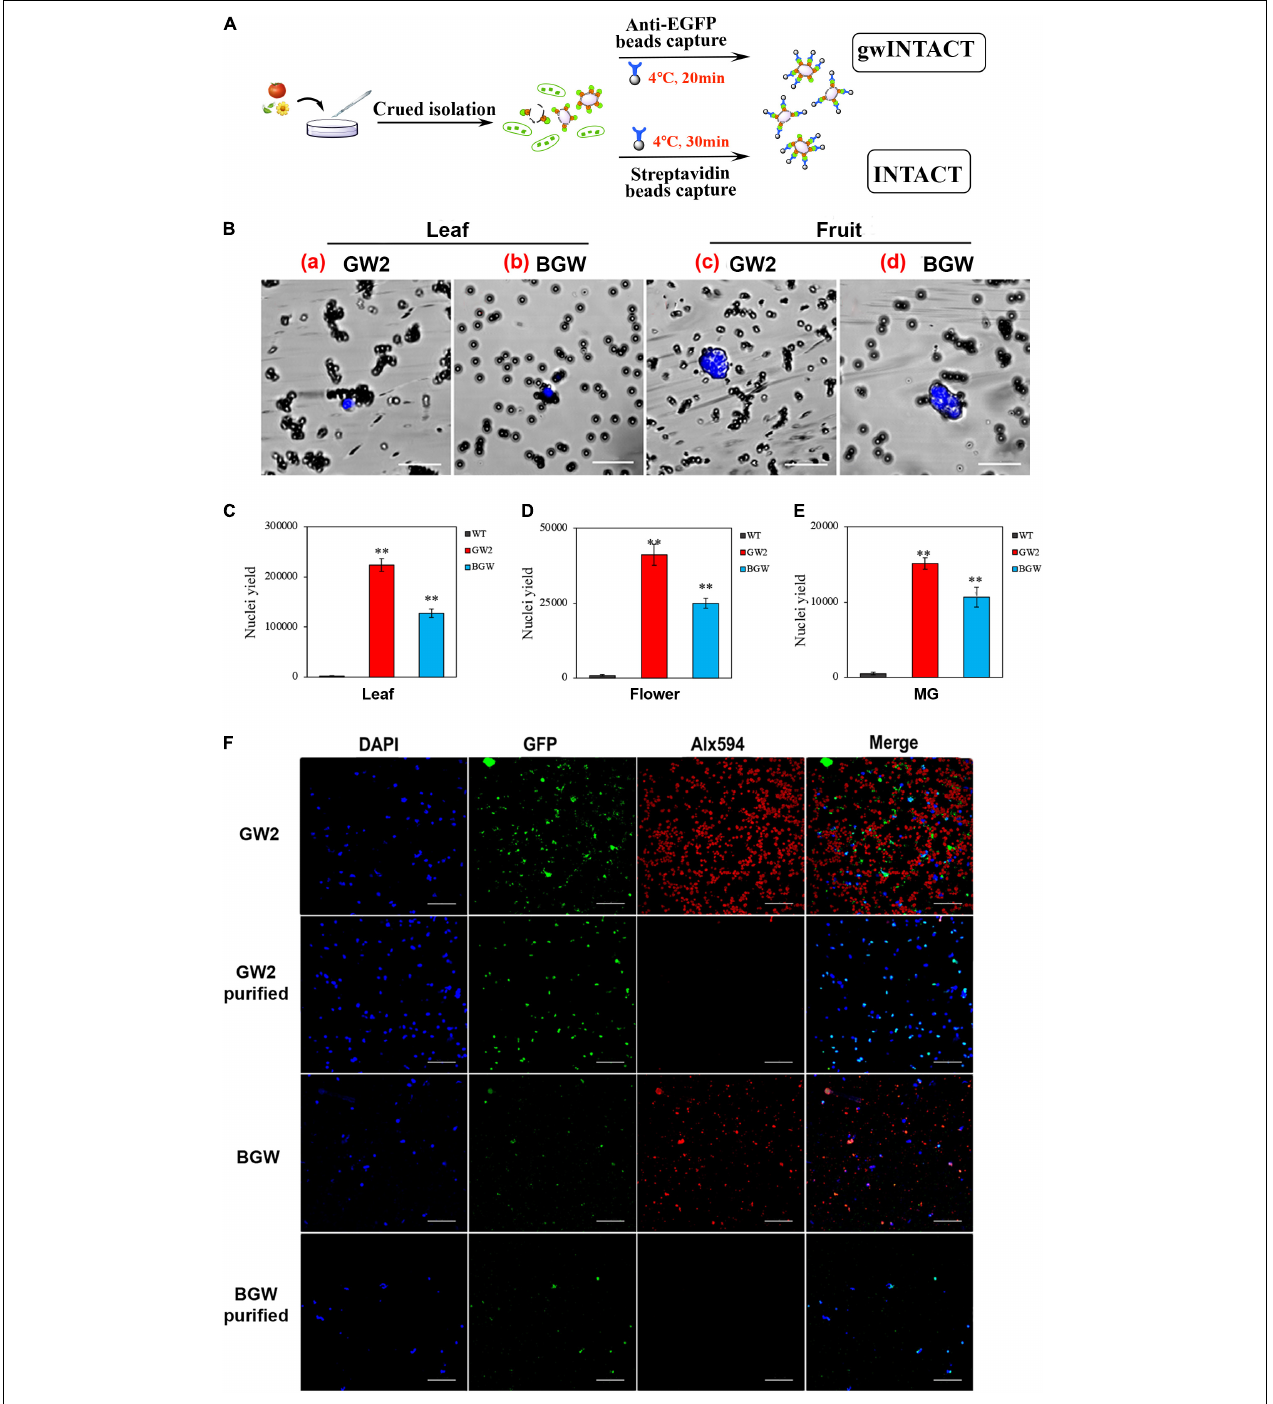
FIGURE 4 | Nuclei separation using INTACT with GW2 protein. (A) The workflow diagram of two different INTACT strategies. The INTACT procedure with GW2 (gwINTACT) is different from BGW and does not rely on the streptavidin-mediated capture of biotinylated nuclei. (B) Microscopy images of purified bead-binding nuclei from different tomato tissues of GW2 lines or BGW lines. Nuclei were stained with 4 (cid:48) ,6-diamidino-2-phenylindole (DAPI; blue) and surrounded by magnetic beads (dark gray) coated with streptavidin (BGW) or eGFP (GW2) antibody. a and b are from leaf tissues, and c and d are from fruit tissues. A single-tagged-nucleus can be bound to several beads. (C-E) Yield of purified nuclei from leaf, flower, and MG fruit tissues expressing GW2 or BGW. The purified nuclei were counted using a hemocytometer. (F) Fluorescence images of nuclei and chloroplasts from leaf tissues of GW2 lines and BGW lines with purification. Nuclei were visualized with DAPI (blue) and GFP (green), and chloroplasts were observed by Alx594 (red). Scale bars: B, 20 µ m; F, 50 µ m. Asterisks indicate significant differences ( ∗∗ p < 0.01) in comparison with wild type (WT).